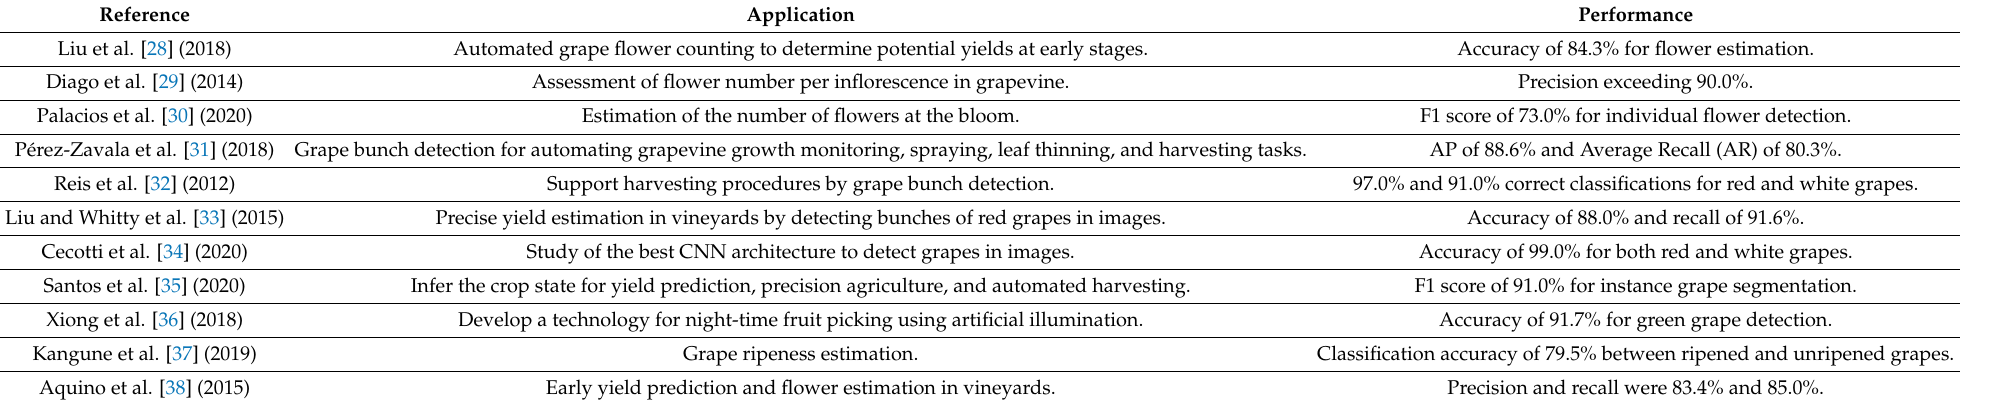
Table 1. Summary of the current state-of-the-art of Deep-Learning (DL)-based grape